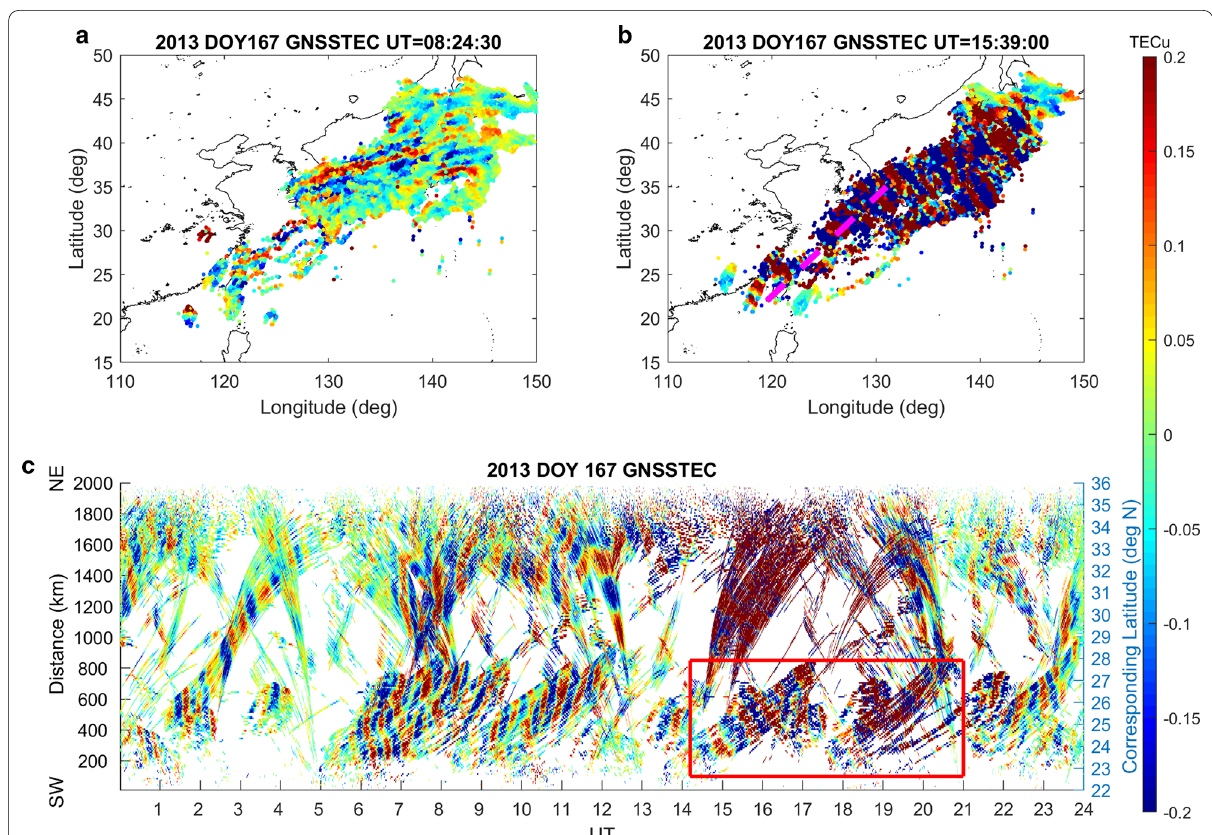
Fig. 5 Daytime and nighttime MSTID propagation over Japan and Taiwan. a An example of typical daytime MSTIDs over mid‑ and low‑latitude region, and b example showing nighttime MSTIDs propagating from Japan to Taiwan. c The filtered TEC perturbations, along the purple dashed line in b , organized as a time–distance